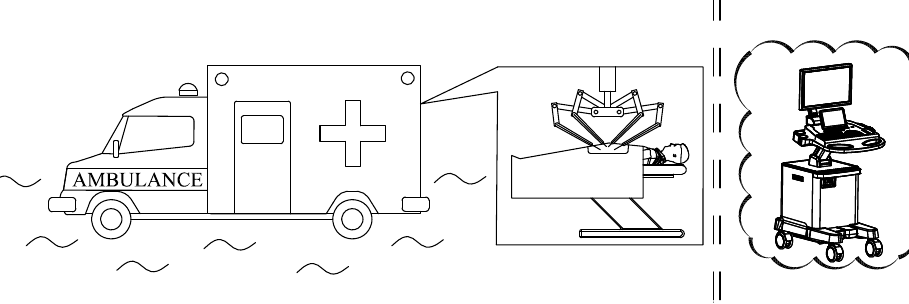
Figure 1. A telesurgery robotic manipulator mounted on an oscillating mobile vehicle as per a healthcare application example. The OBM is considered working in the non-inertial task space attached with the mobile